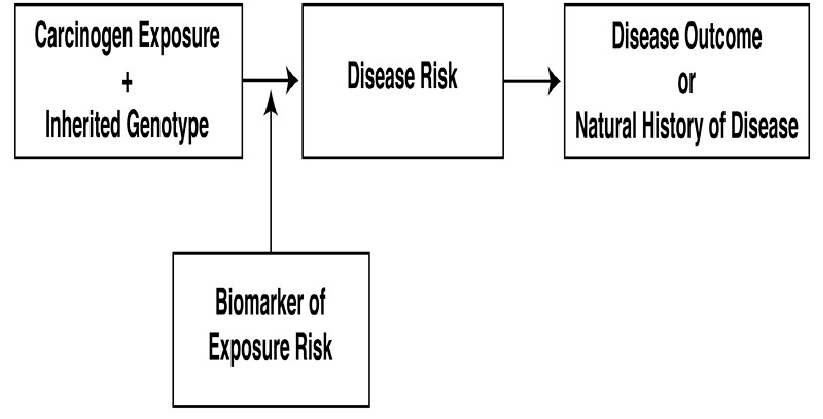
Figure 3. Rebbeck’s predictive multistage model of carcinogenesis [29].